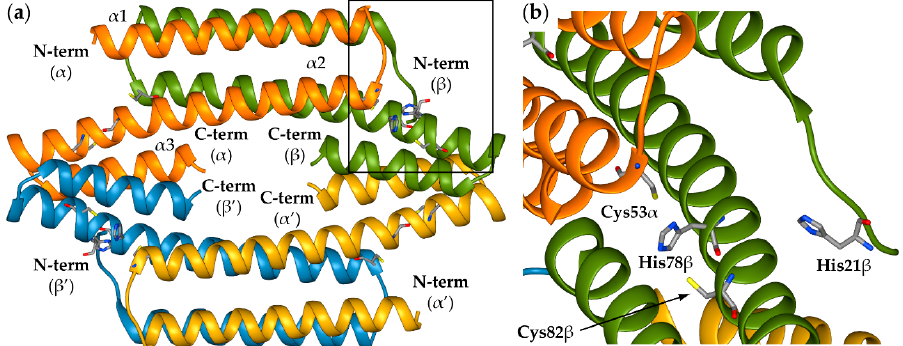
Figure 2. ( a ) Ribbon diagram of Sy InrS crystal structure (PDB id: 5FMN [17]). Chains α , β , α ’, and β ’ are coloured in orange, green, yellow, and light blue, respectively. ( b ) Detail of the putative metal binding region [black square in panel ( a )]. Proposed Ni(II) binding residues are reported as sticks coloured accordingly to the atom type.